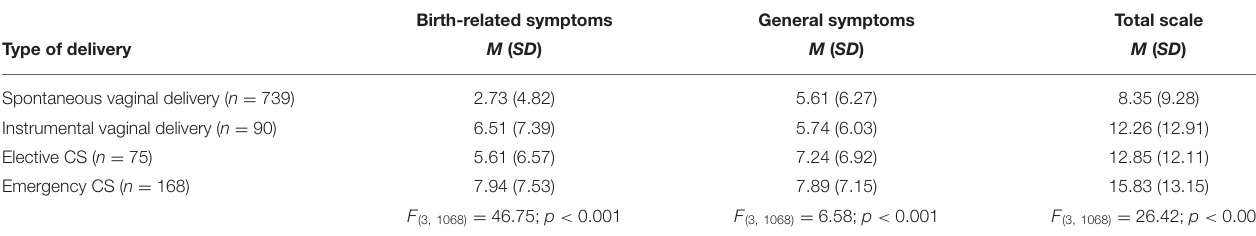
TABLE 5 | Differences in the City BiTS subscales and the total scale for type of